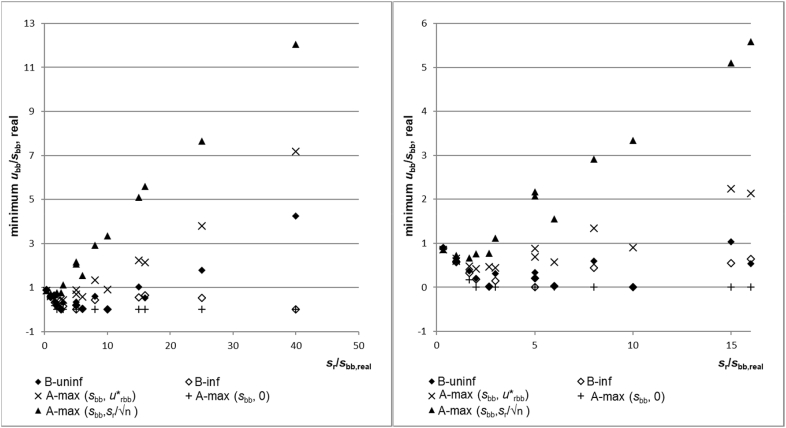
Maximum underestimation of sbb,real. Left all srsbb, real ratios. Right: only area for sr/sbb,real up to 16. Numbers below 1 correspond to an underestimation of the real between-unit variation; values above 1 show that even the lowest estimate of ubb was above sbb,real.